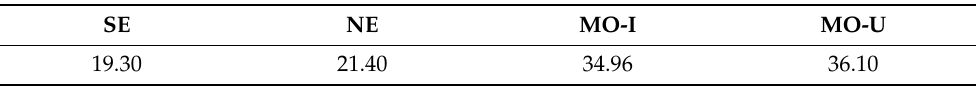
Table 4. Maximum value of electric field stress in oil wedge in (kV/mm) corresponding to inception voltage from previous measurements.